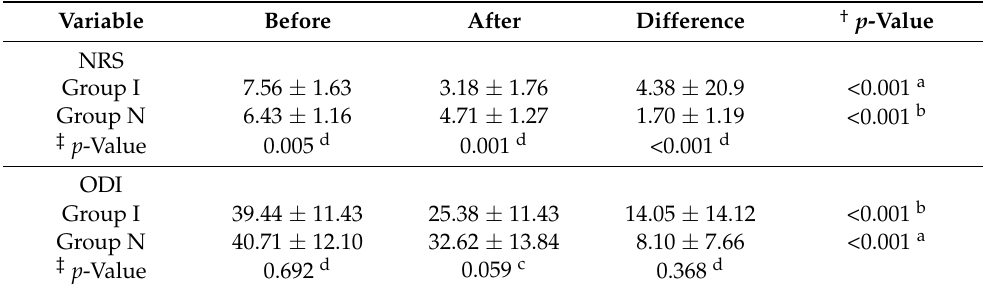
Table 2. Comparison of NRS score and ODI score before and after PPDD. Variable Before After